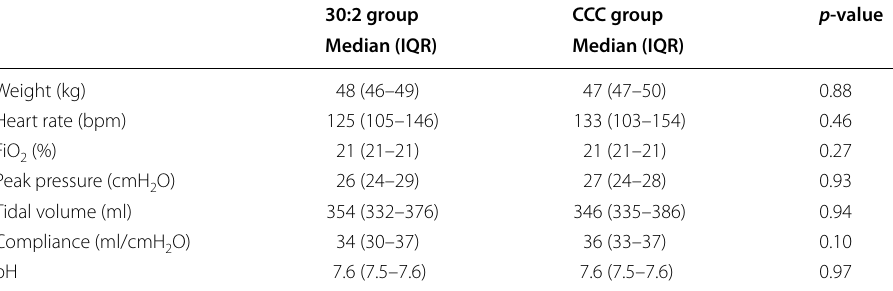
IQR: interquartile range; CCC: continuous chest compressions; bpm: beats per minute; FiO 2 : fraction of inspired oxygen Table 2 Vital signs and interventions during cardiopulmonary resuscitation